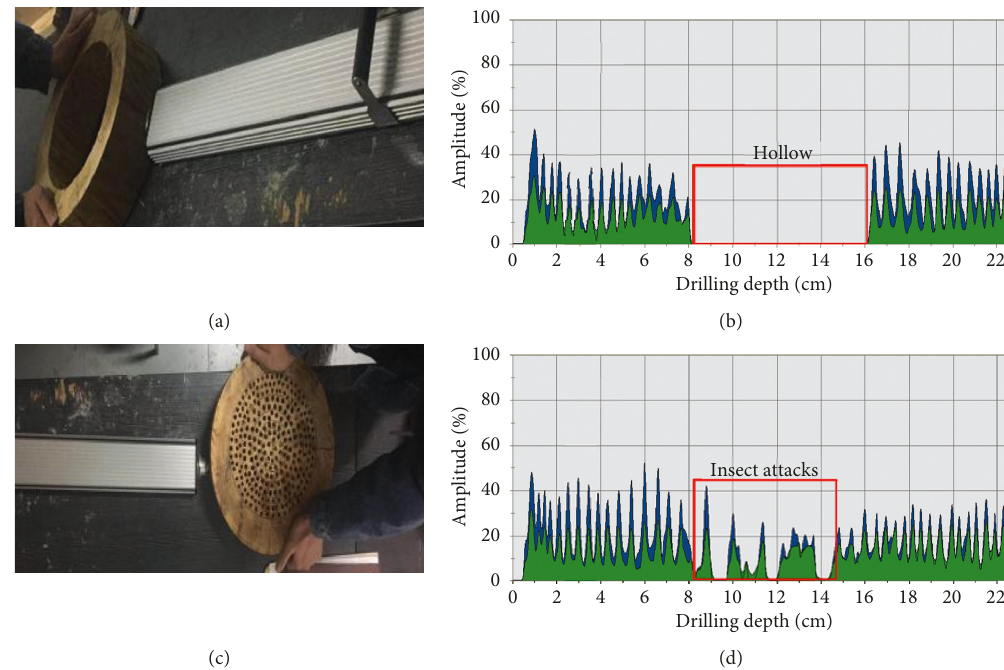
Figure 6: Drilling resistance tests: (a) hollow and (b) its two-dimensional image; (c) insect attacks and (d) their two-dimensional